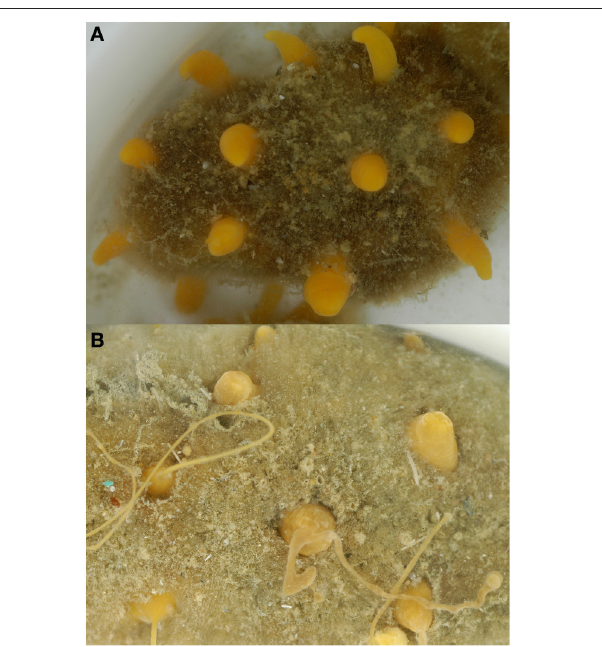
FIGURE 1 | Sphaerotylus antarcticus in (A) summer and (B) winter. In summer the oscular papillae were generally short and wide and in winter some of the oscular papillae elongated and narrowed and grew long filaments with asexual buds along their length. In summer C. nidificata produced significantly more ammonia ( T > 9.0, P < 0.01), whereas Suberites sp. produced significantly less ammonia ( T > 10.5, P < 0.01) than other sponges species investigated ( Figure 3 ). Suberites sp. exhibited the only seasonal difference in ammonia production, with an increased production in winter ( T = 10.9, P <